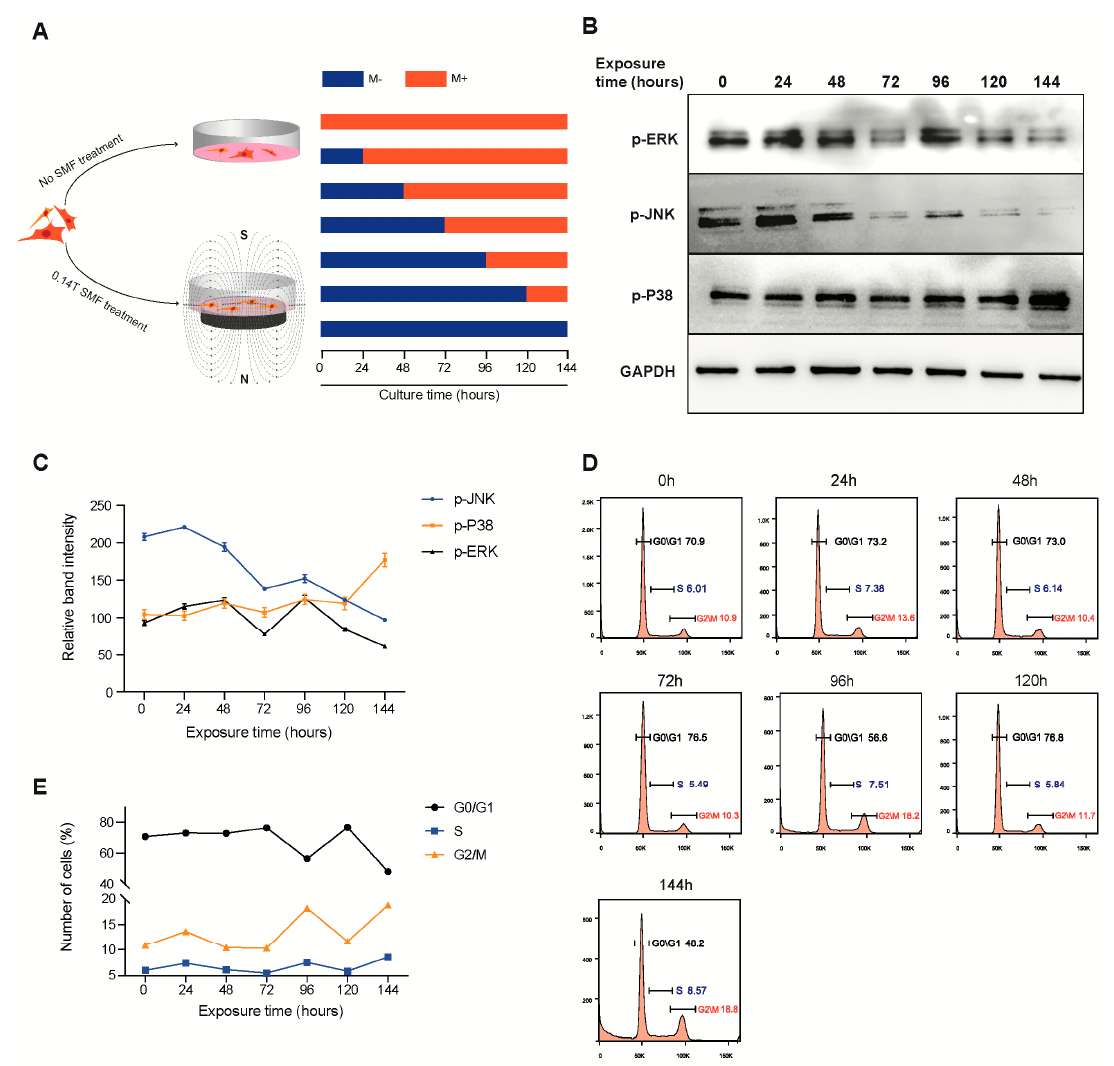
Figure 3. SMF exposure time modulates the activation of ERK and p-ERK protein in MSCs. ( A ) Schematic of experimental approach. ( B ) The representative results of Western blot of p-JNK, p-ERK, and p-P38 in MSCs cultured for 6 days, exposed at SMF for 0–144 h. ( C ) The graph showing relative band intensities of p-JNK, p-ERK, and p-P38 shown in ( A ). Data are mean ± s.d., N = 3 independent experiments. ( D ) The distributions of cell cycle after exposure for 0, 24, 48, 72, 96, 120, and 144 h to SMF were analyzed with flow cytometry. ( E ) The line chart of G0/G1, S, and G2/M phase distributions after exposure for 0, 24, 48, 72, 96, 120, and 144 h to 140 mT SMF. These data indicate that the length of SMF exposure time triggers the MSC cell-cycle distribution via activation of the ERK/JNK-MAP kinase signaling pathway.